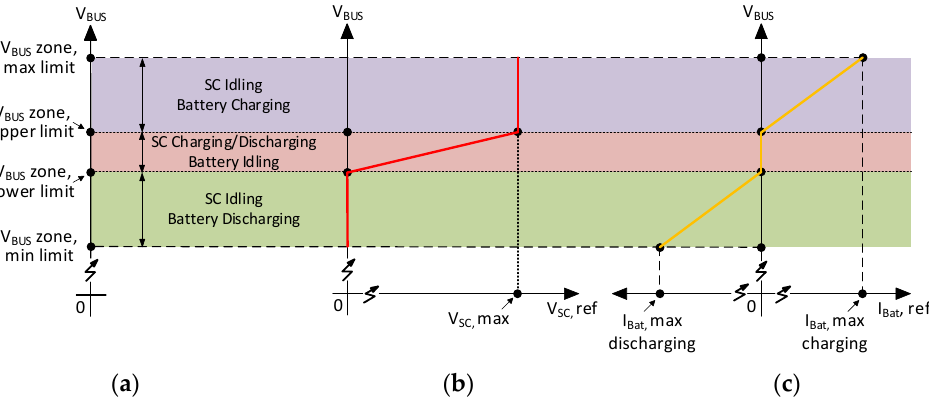
Figure 5. ( a ) The working principle of the proposed SCES/battery HESS control algorithm; ( b ) the droop curve with multiple segments for the SCES; ( c ) the droop curve with multiple segments for the ba tt ery.